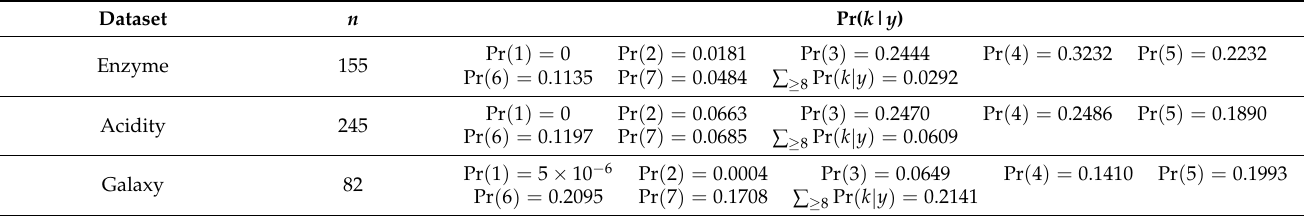
Table 6. Posterior distribution of k for enzyme, acidity, and galaxy datasets based on mixture model using the EV-I distribution.